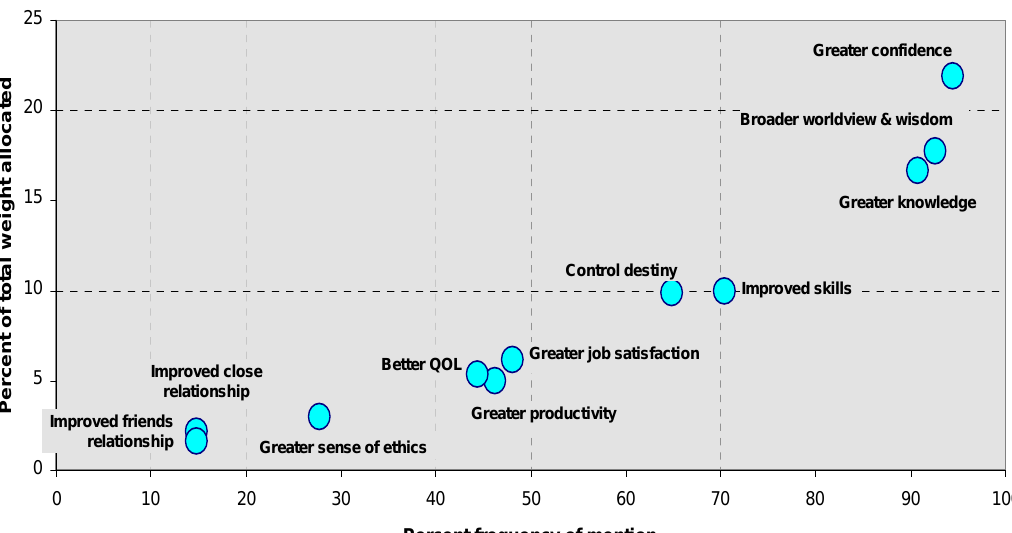
Figure 6: The perceived financial benefits of an MBA